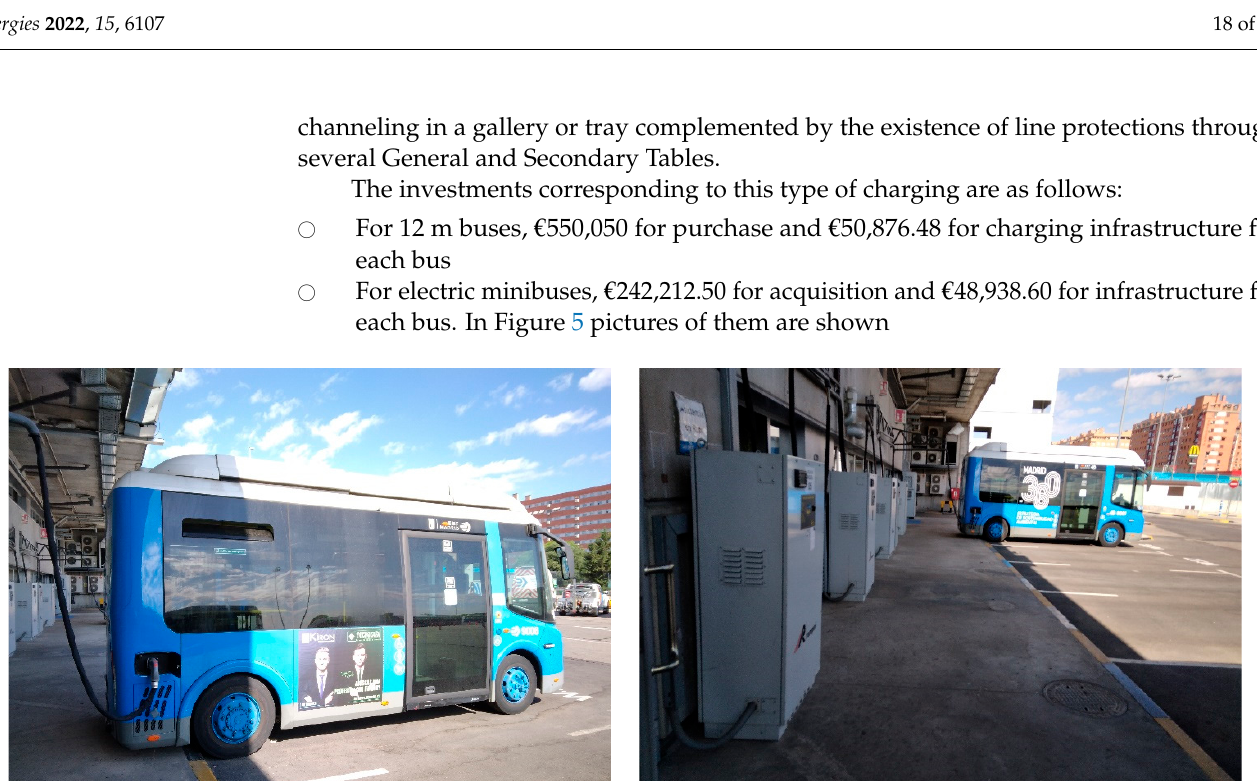
Figure 4. Pictures of wired charging in Carabanchel OC (Madrid), funded by FEDER funds, EU.  The one corresponding to electric minibuses that has 80 kW chargers